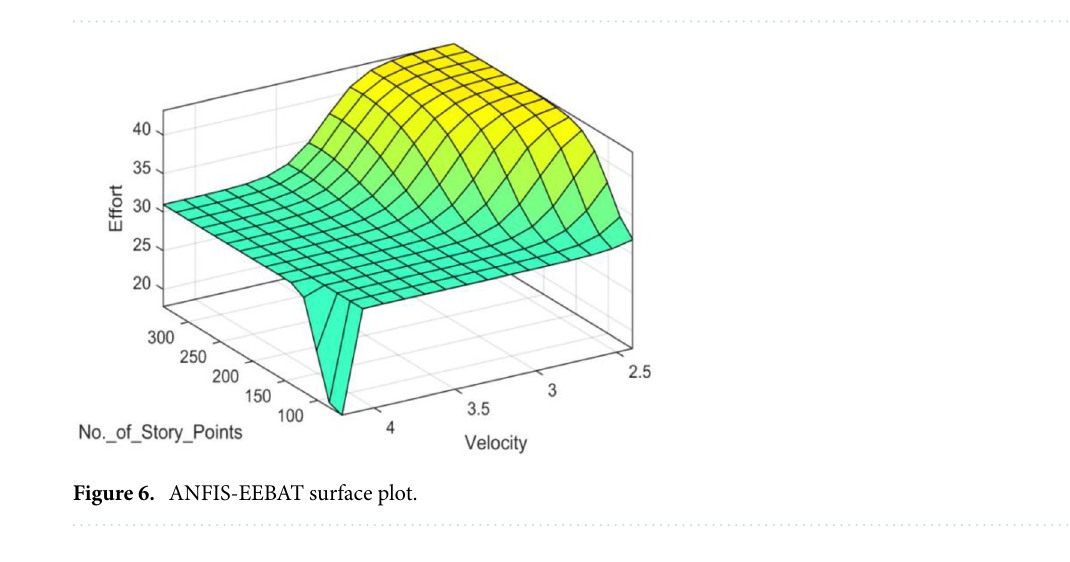
Figure 5. ANFIS-EEBAT rules view. Each row of plot represents a rule. There are a set of four rules based on input and output membership functions. The red line is a slider for selecting the input values. For instance, we have selected the value of “No. of Story Points” as 84.8 and “Velocity” as 2.48. The yellow color in the plots depicts how input variable is used in the rules. The blue color in the output membership function, “Effort”, signifies how output is utilized in the rules. The output of each rule is combined and defuzzified to create an aggregated output in the bottom-right plot. The estimated effort, 33 is the output and is shown by the red color line.